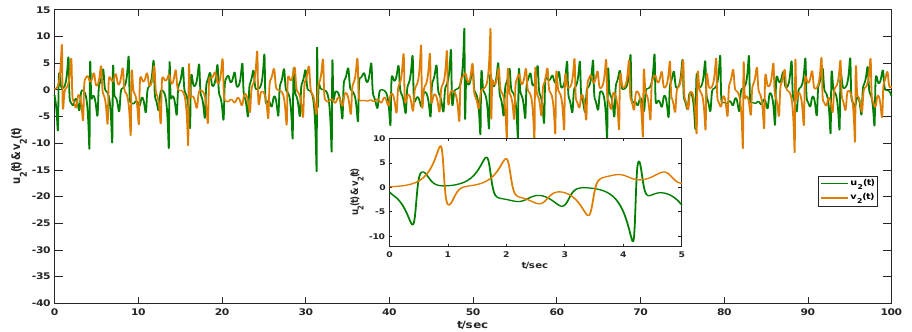
Figure 10. Time response of the states ( t , u 2 ( t )) and ( t , v 2 ( t )) of the drive-response systems (13) and (14) with fractional order q = 0.9.